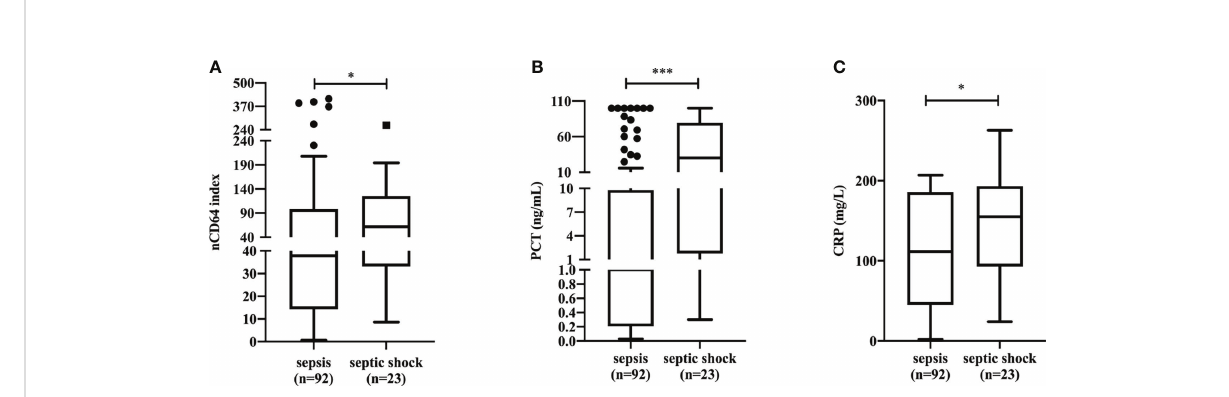
FIGURE 4 The differences of nCD64 index (A) , PCT (B) , and CRP (C) in sepsis patients with and without shock. The comparisons of nCD64 index, PCT and CRP between two groups were performed using Mann-Whitney U test. * P <0.05, *** P <0.001. nCD64, neutrophil CD64; PCT, procalcitonin; CRP, C-reactive protein; ns, no signi fi